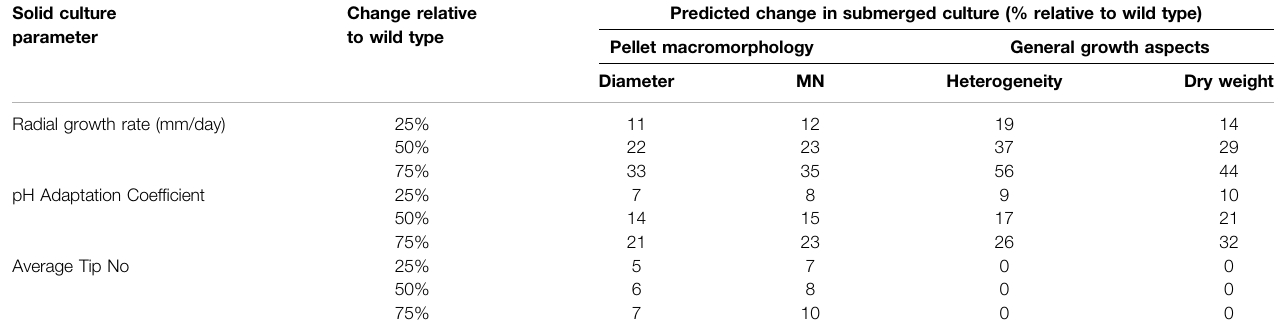
TABLE3| Regressionmodelsusedtopredicthowchangesinstrain fi tness/hyphalgrowthimpactedsubmergedmacromorphologies.Testvariableswereonlyincorporated into the regression model where p < 0.05. Note that tip number was not predicted to signi fi cantly impact heterogeneity or dry weight. Solid culture parameter